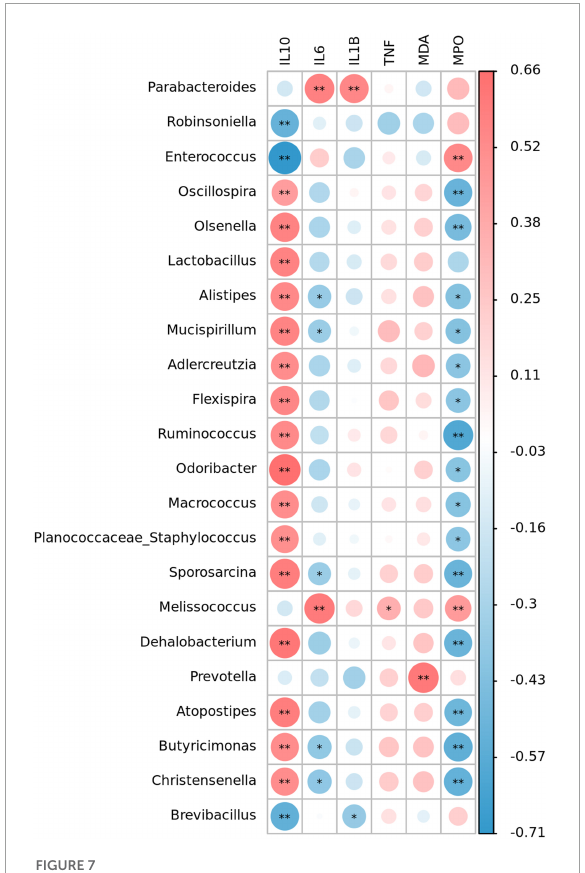
FIGURE7 Heat map representation of the Spearman’s correlation coefficient between bacterial taxa and colitis-related index (IL-10, IL-6, IL-1 β , TNF- α , MDA, and MPO). Positive correlation is represented in red and negative correlation is represented in blue. Significant differences are indicated as ∗ P < 0.05, ∗∗ P <